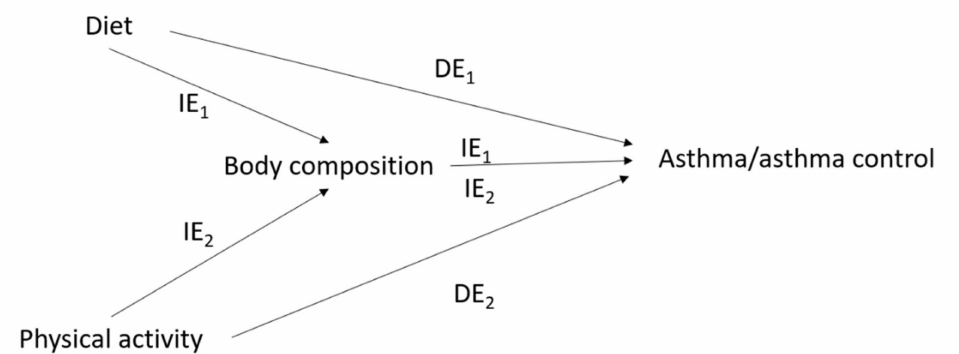
Figure 1. Issue of mediation* in the interrelations between nutritional factors and asthma/asthma control. IE 1 = indirect effect of diet on asthma/asthma control mediated by body composition; IE 2 = indirect effect of physical activity on asthma/asthma control mediated by body composition; DE 1 = direct effect of diet on asthma/asthma control; DE 2 = direct effect of physical activity on asthma/asthma control; * For simplicity, the time-dependent nature of the interrelations between nutritional factors and asthma, and their covariates, is not represented in this figure (see Figure